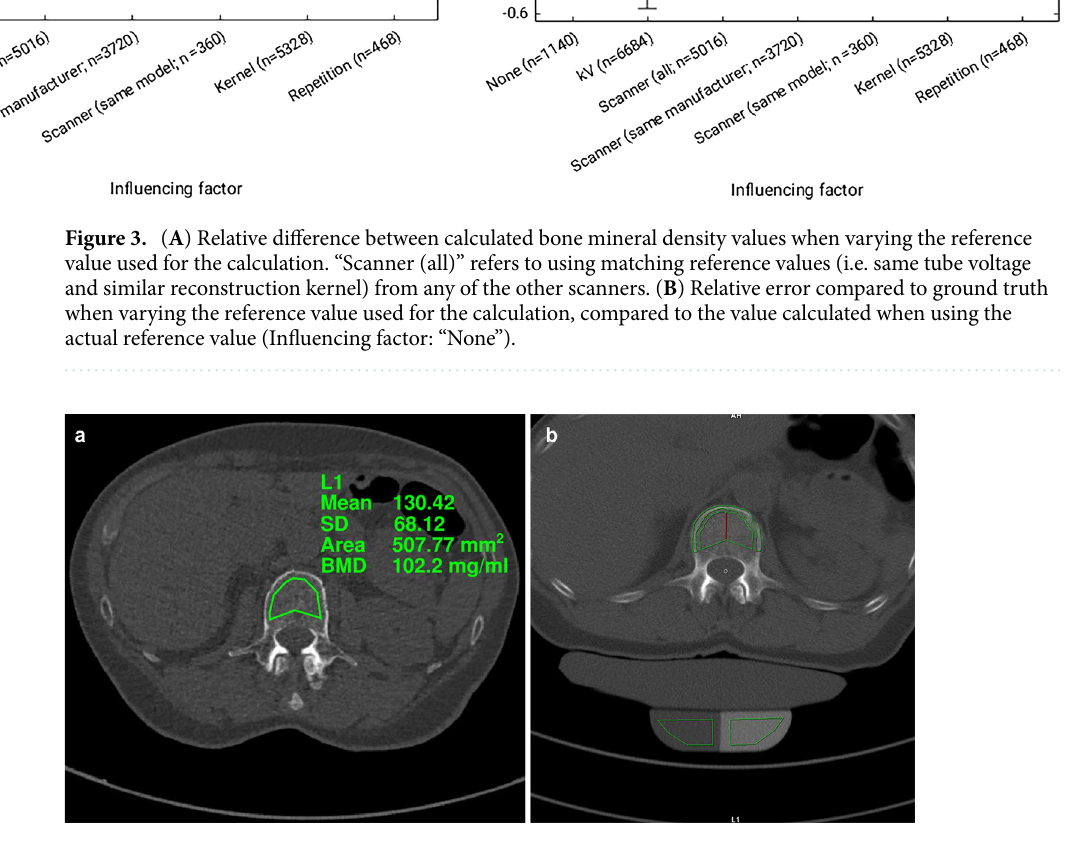
Figure 4. Image example comparing bone mineral density (BMD) measurements in terms of hydroxylapatit concentrations with synchronous and asynchronous calibration. ( A ) BMD measurement in the first vertebra of the lumbar spine (L1) of an 84-year-old female, showing a BMD of 102.2 mg/ml. BMD is calculated based on CT numbers of a non-contrast CT scan using the asynchronous reference values determined in this study. ( B ) Automated segmentation of L1 in the same 84-year-old female scanned with the reference phantom using syngo Osteo CT (Siemens Healthineers). Reported BMD of 96.2 mg/ml for L1 using synchronous